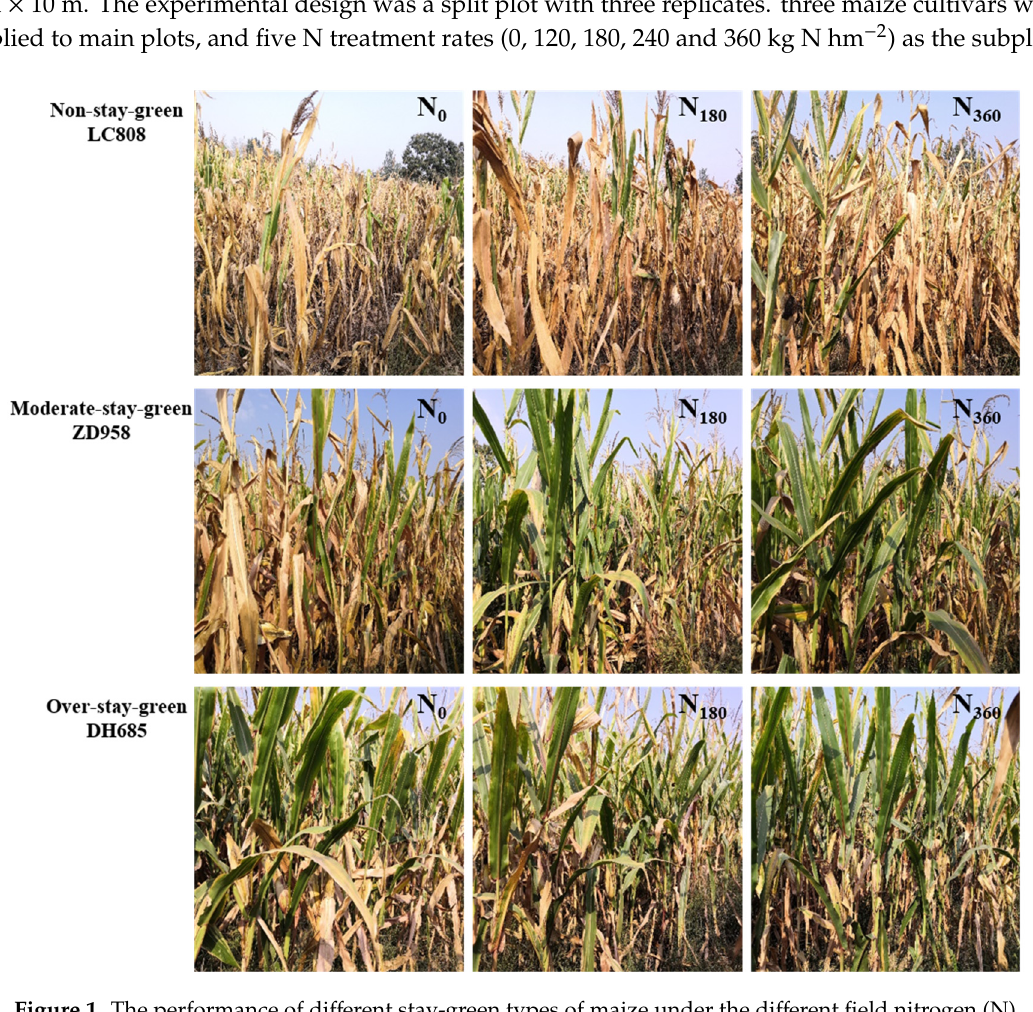
Figure 1. The performance of different stay-green types of maize under the different field nitrogen (N) levels at the maturation stage.